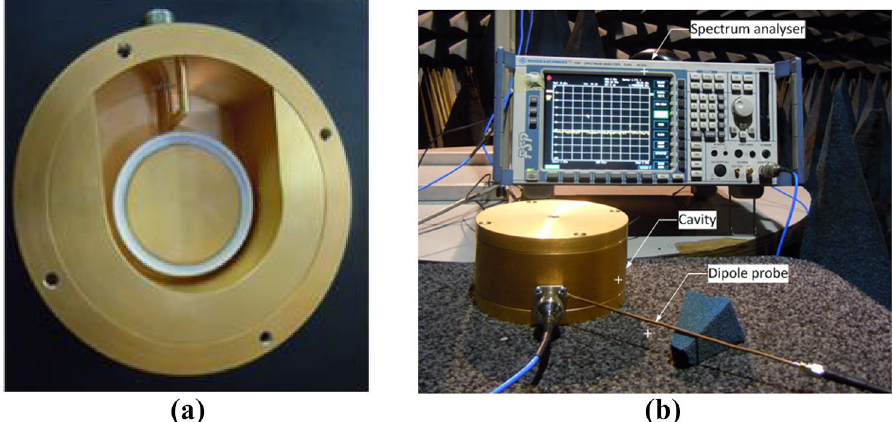
Figure 10. Testing of the fabricated prototype; ( a ) Fabricated exposure system; ( b ) Experimental setup.